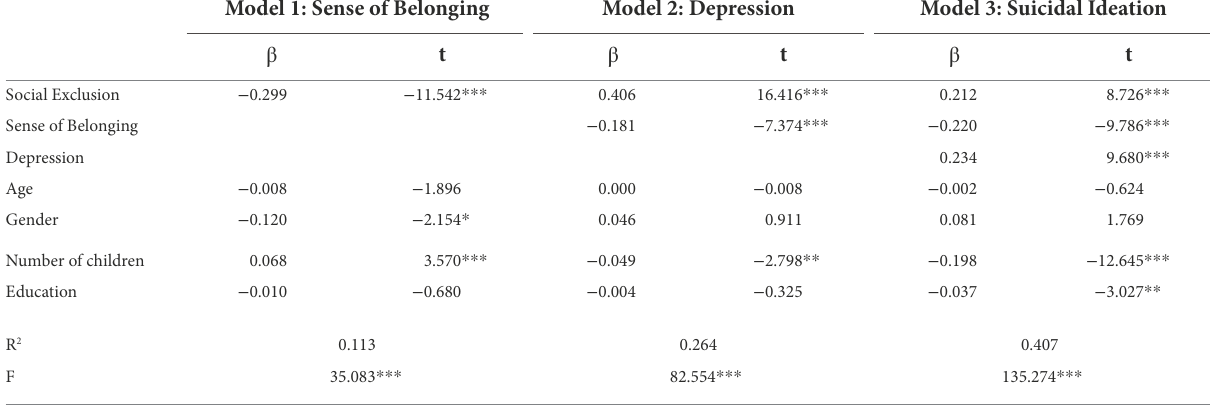
TABLE 2 Testing chain mediation effect of sense of belonging and depression.